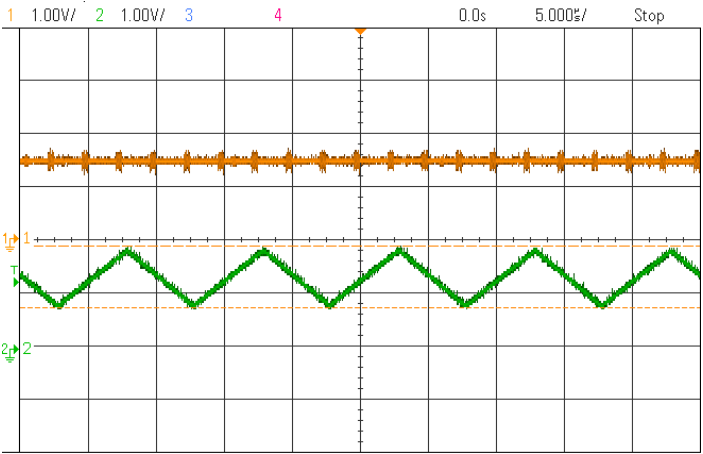
Figure 11. Comparison between a high-speed (lower wave) and low-speed (higher wave) DACs. The steady-state of a buck converter following the architecture of Figure 7b.